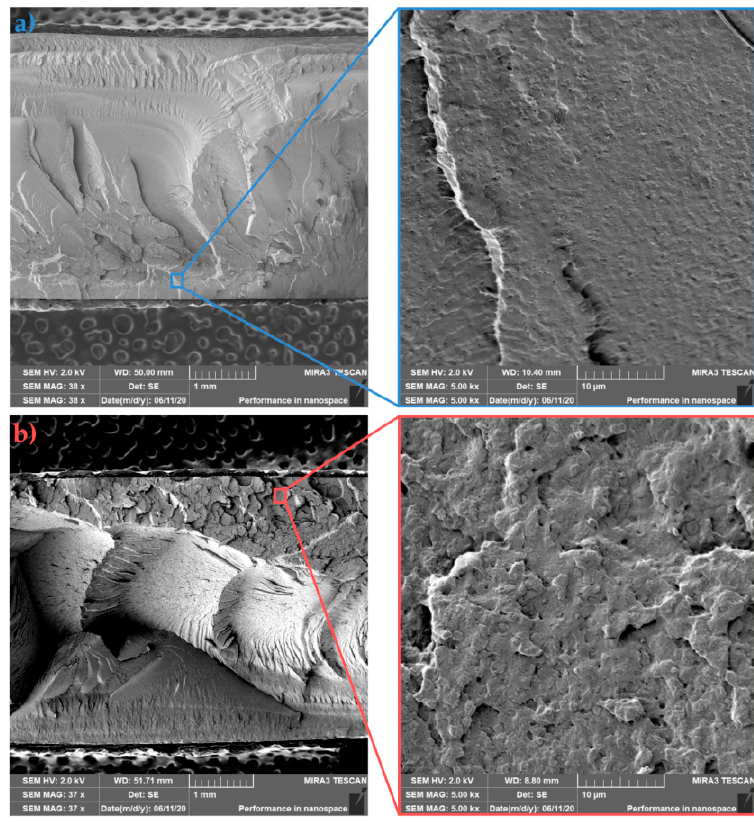
Figure 9. Fracture morphologies of ( a ) cold and ( b ) hot mold PLLA.